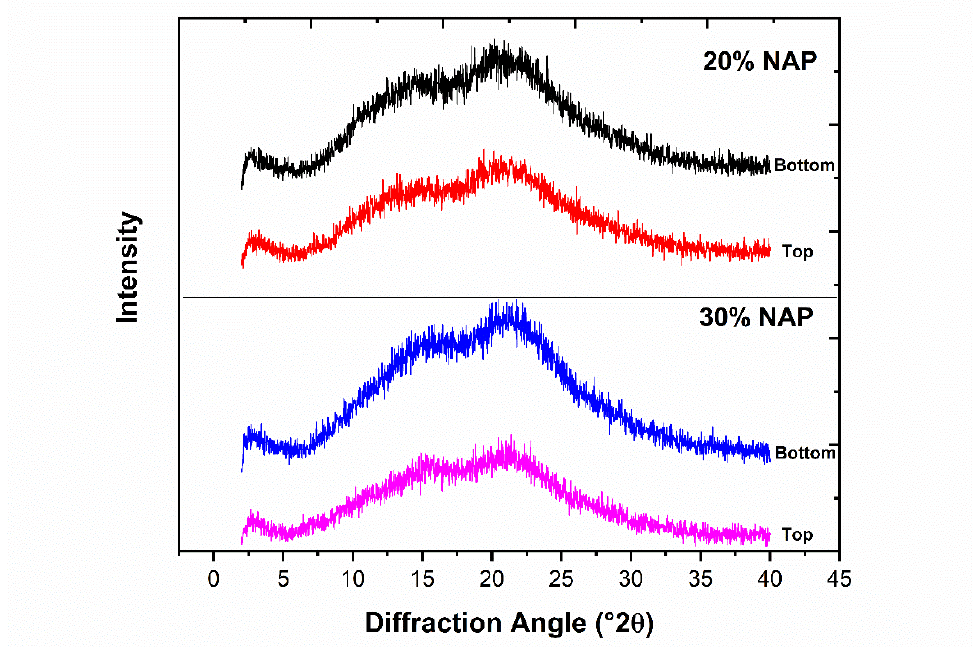
Figure 8. Diffractograms from the top and bottom sides for the 3D-printed tablets after 23 weeks of storage at 37% relative humidity (RH) and 298 K.